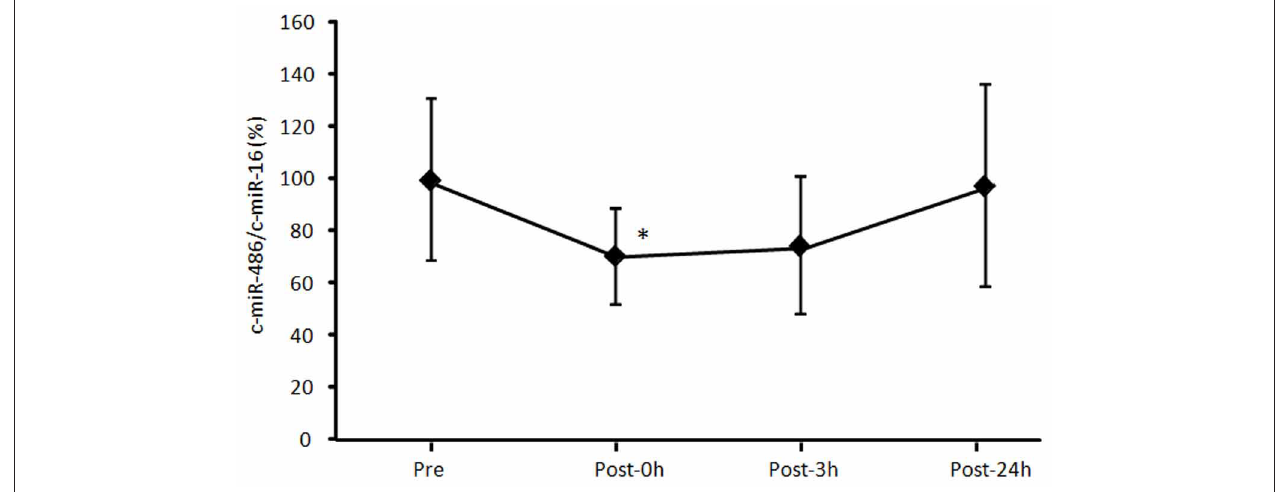
FIGURE A1 | Time-course change of circulating miR-486 in response to acute exercise. The level of circulating miR-486 was determined before (Pre) and immediately (Post-0h), 3h (Post-3h), 24h (Post-24h)